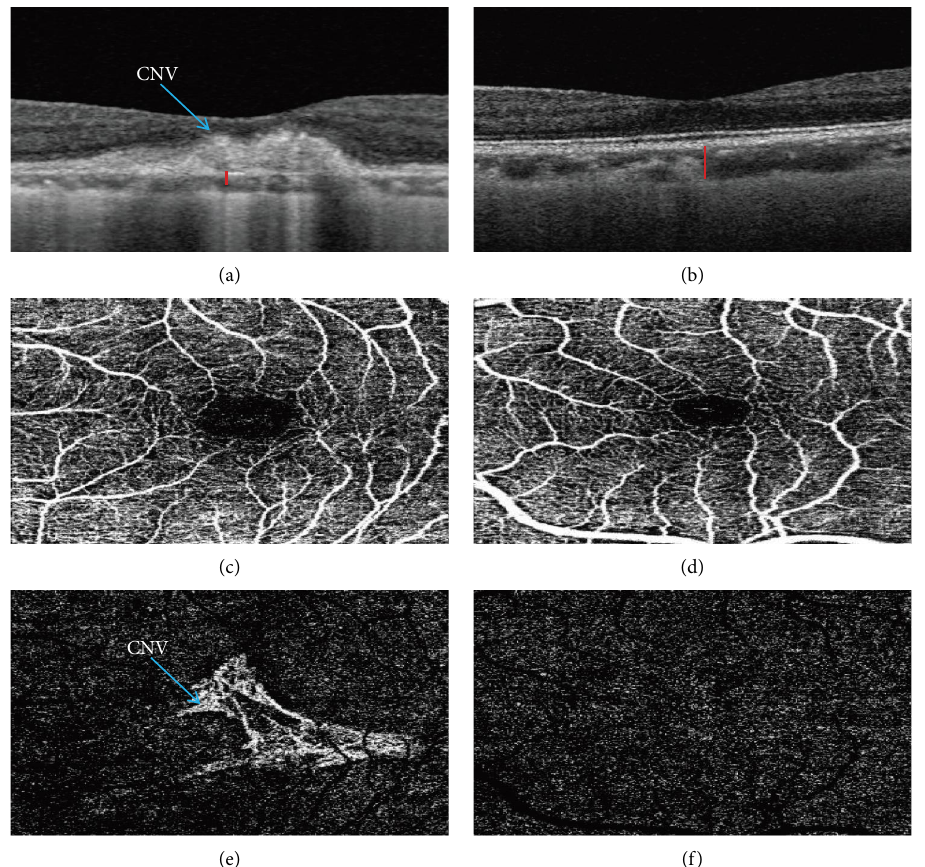
Figure 1: Representative example of swept-source optical coherence tomography (OCTA) images. (a and b) show an OCTA B-scan of high myopia with and without choroidal neovascularization (CNV), respectively. Te red lines represent choroidal thickness. (c and d) show the superfcial retinal layer on the macula in high myopia with and without CNV, respectively. (e and f) show a deep retinal layer on the macula in high myopia with and without CNV,